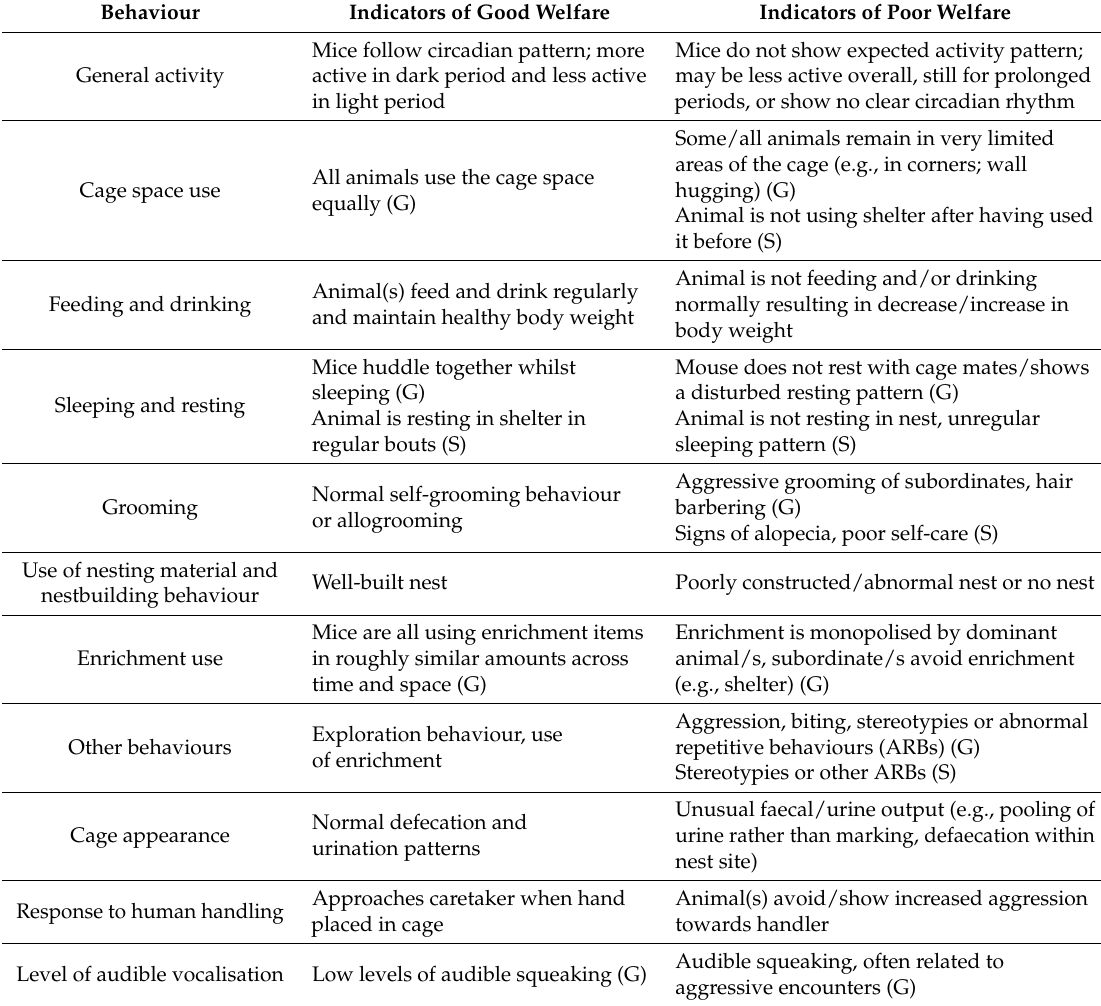
Table 5. Welfare indicators for group- or individual-housed male